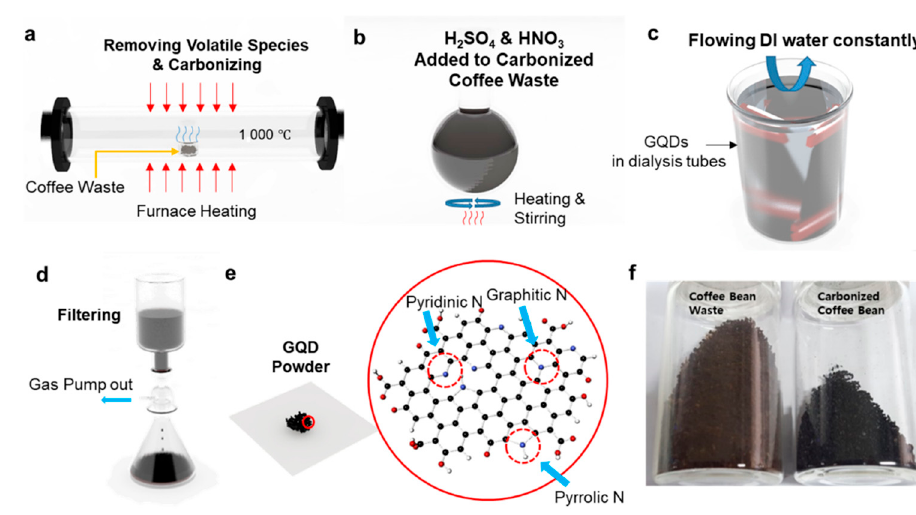
Figure 1. Schematic illustration of the synthesis of coffee bean-derived GQDs, ( a ) Carbonization process to remove undesirable chemicals in coffee beans at 1000 °C with hydrogen gas, ( b ) The resulting carbon precursor was refluxed in H 2 SO 4 and HNO 3 (3:1) solution at 100 °C, ( c ) The obtained solution is dialyzed in a dialysis bag to remove acid, ( d ) To discard unreacted carbon debris, the solution was vacuum filtered with a membrane filter, ( e ) Schematic illustration of as-synthesized coffee bean-derived GQDs. The graphitic plane of the GQDs consists of pyrrolic, pyridinic, and graphitic nitrogen, respectively, ( f ) Photo images of coffee beans pre- and post-carbonization process.